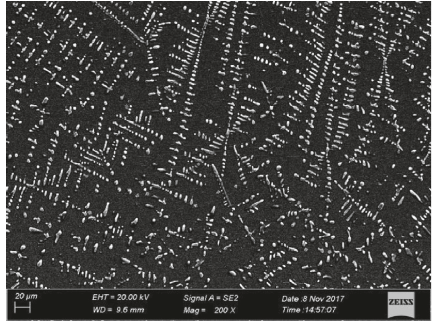
Figure 3: Microstructure of Cu-15 wt.% Fe at ∆ T